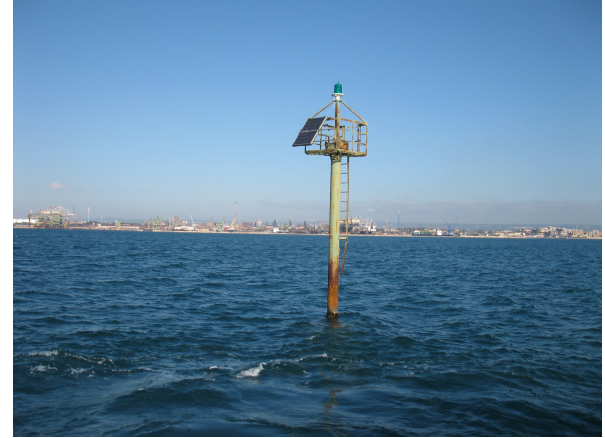
Figure 2. Seamark where the monitoring station in the Mar Grande was